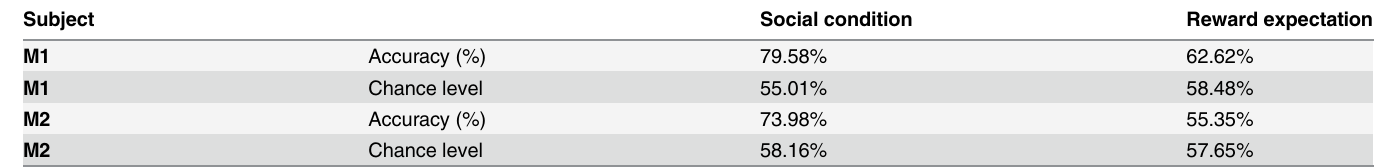
Table 2. The results of social condition classifier, reward expectation classifier and chance level of these